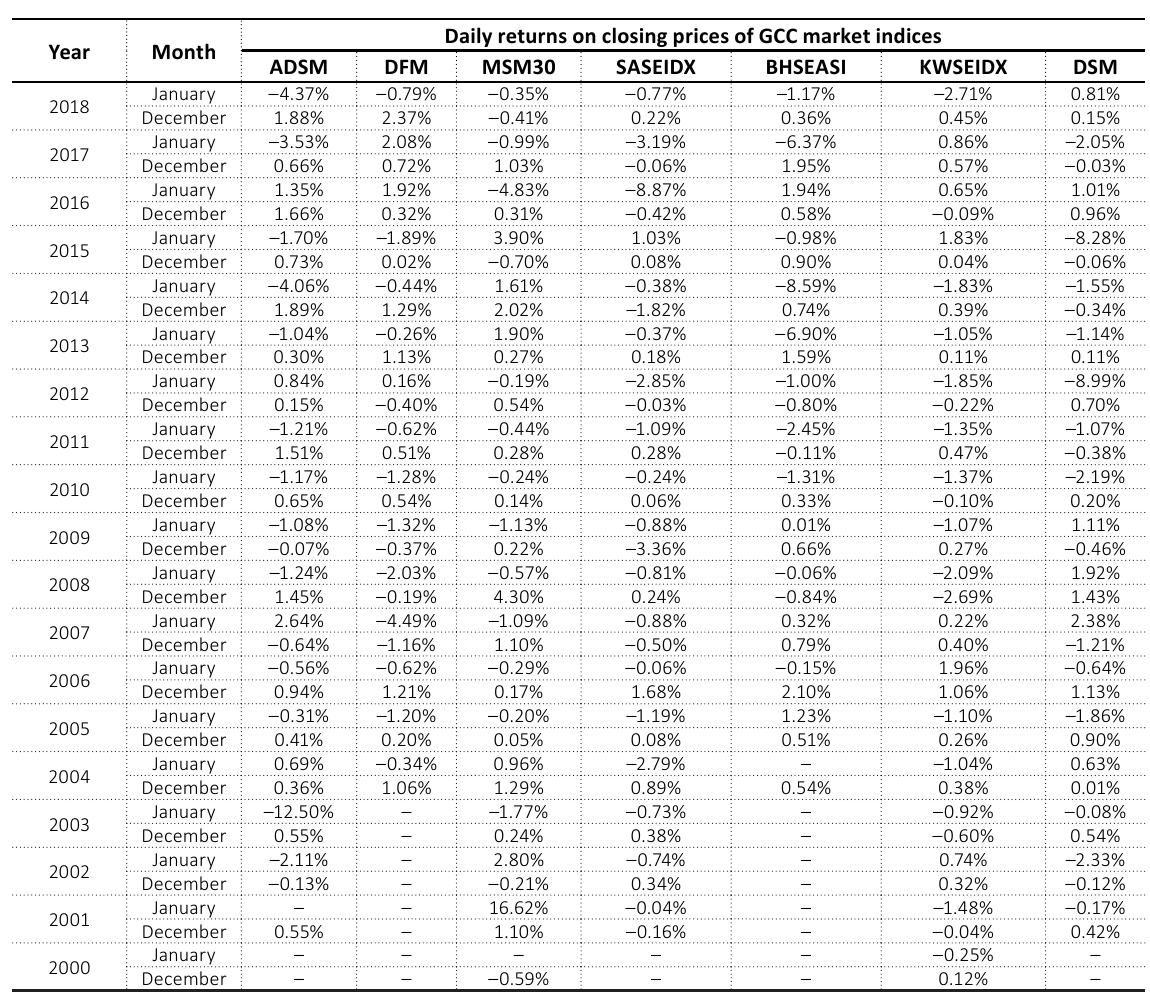
Table 2. Monthly returns on closing prices of GCC market indices